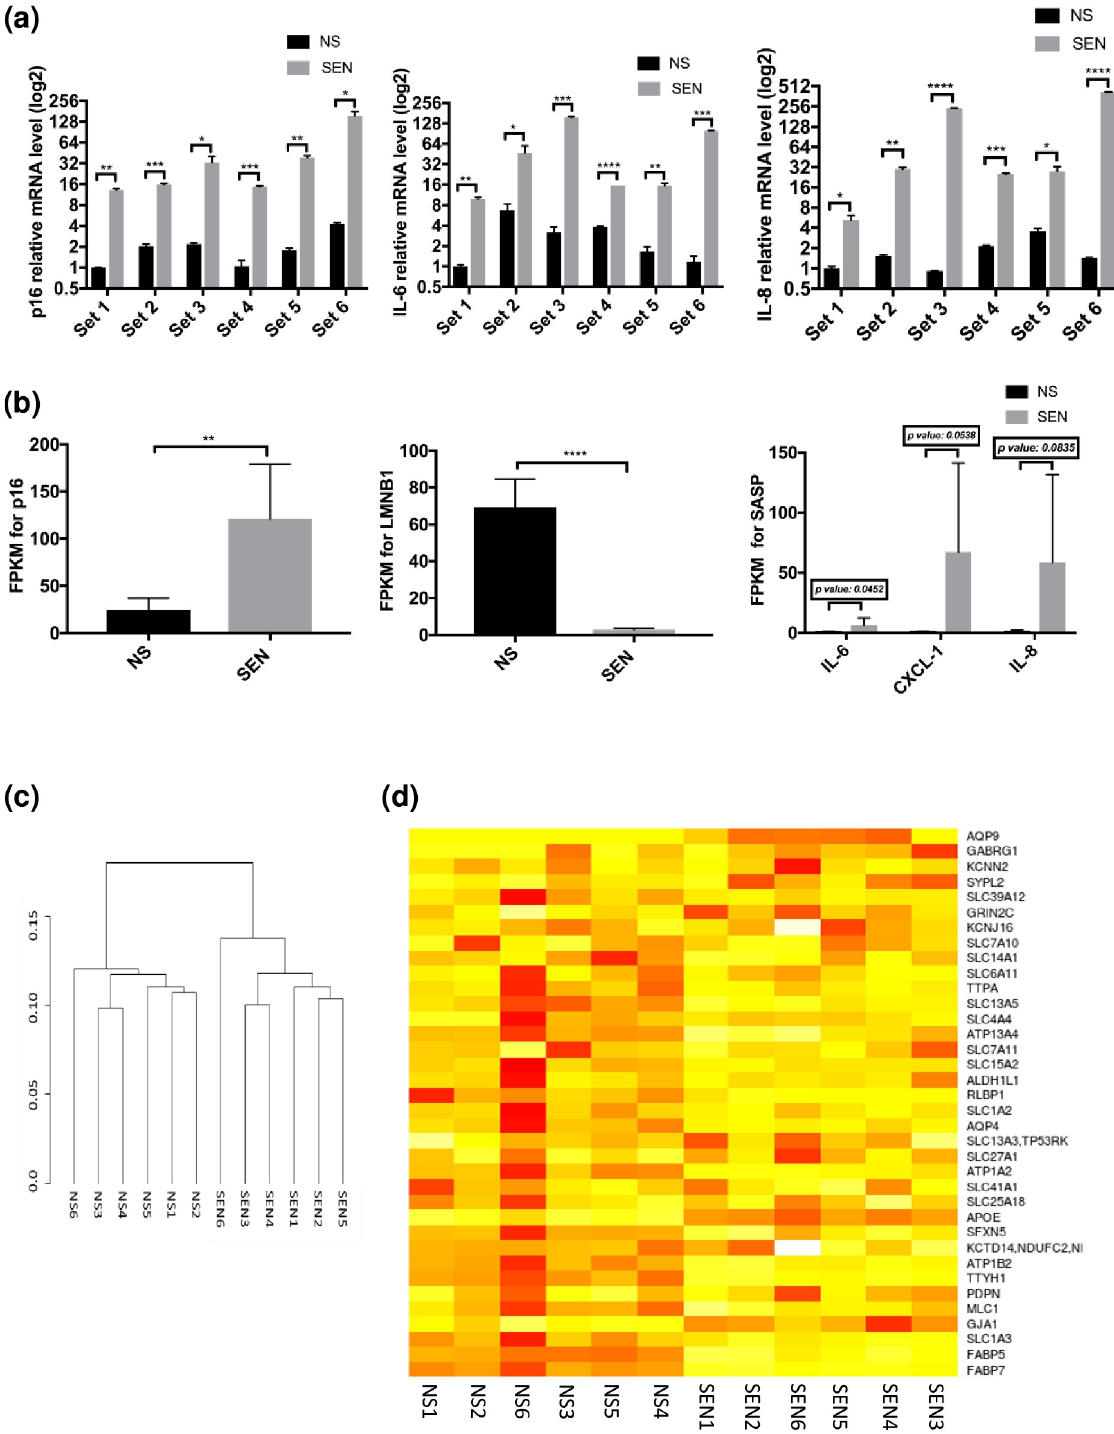
Fig 3. RNA-seq data reveal genes regulated in astrocytes upon senescence induction. (a) RNA extracted from SEN astrocytes corresponding to 6 different human cell strains was compared to RNA extracted from NS samples. p16 INK4a and SASP factors (IL-6 and IL-8) were analyzed by real-time PCR. (b) RNA-seq results (presented as Fragments Per Kilobase Million or FPKM) for the expression of various genes, i.e., p16 INK4a (left panel), LMNB1 (center panel) and IL-6, IL-8, CXCL-1 (right panel) were compared between NS and SEN samples. (c) Hierarchical clustering using the Jensen-Shannon distance metric was used to determine the similarity within the 6 NS samples and within the 6 SEN samples. (d) A heatmap based on FPKM of Transporter-associated Astrocyte Enriched Genes (TAEG) in all the NS and SEN samples is shown. For (a), n = 2s. For (b), n = 3. For (a, b): � p < 0.05, �� p < 0.02, ��� p < 0.001, ���� p < 0.0001 (unpaired t test). https://doi.org/10.1371/journal.pone.0227887.g003 PLOS ONE | https://doi.org/10.1371/journal.pone.0227887 January 16,